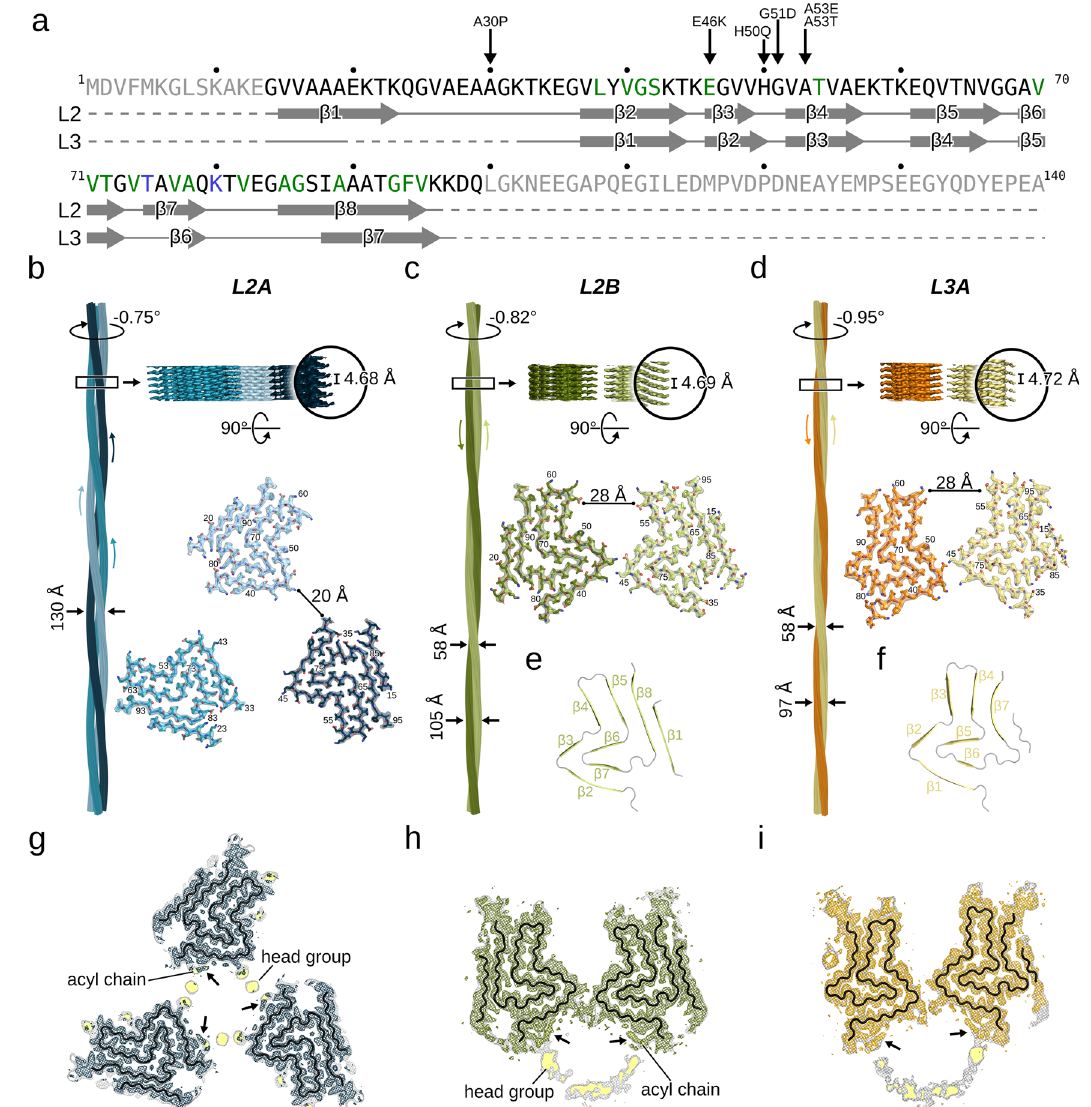
Fig. 2 | Cryo-EMstructures ofL2and L3 α Syn fi brils. a See Fig. 1a for details. b – d Cryo-EM structures of L2A ( b ), L2B ( c ), and L3A ( d ) fi brils (proto fi laments colored differently). The atomic models are shown as sticks. Labels denote the fi bril width, thehelicaltwistandrise,andresiduenumbers.Thedensitymapsinthelowerpanels are displayed using the carve feature in PyMOL at a distance of 2Å. e , f Backbone